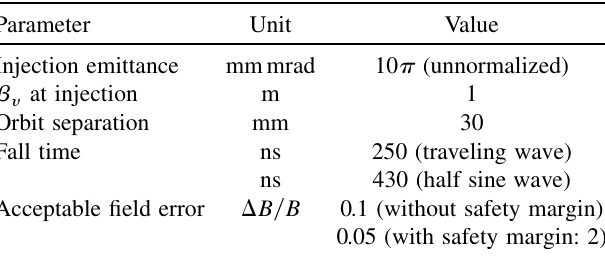
TABLE XVII. Specifications of injection kicker pulse.